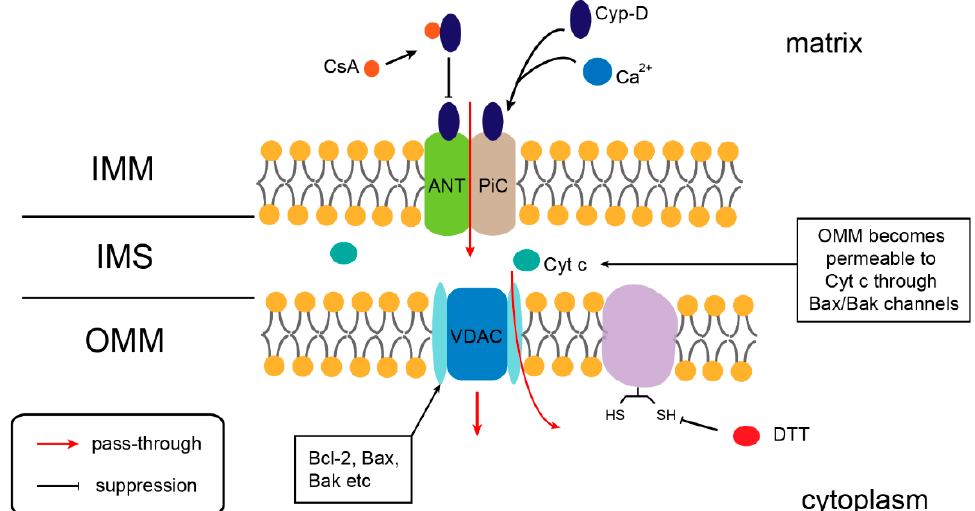
Figure 2. The structure of MPTP. Adapted with permission from Ref. [64]. 2015, Halestrap, A.P. More details on “Copyright and Licensing” are available via the following link: https://www.mdpi.com/ethics#10. IMM: inner mitochondrial membrane; OMM: outer mitochon-